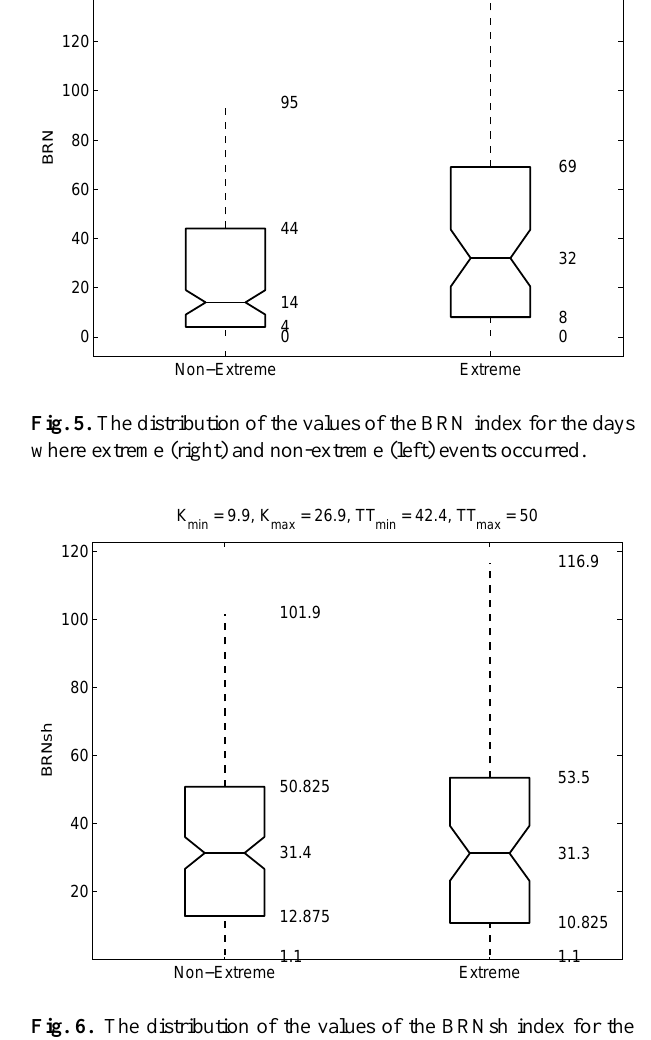
Fig. 5. The distribution of the values of the BRN index for the days where extreme (right) and non-extreme (left) events occurred.